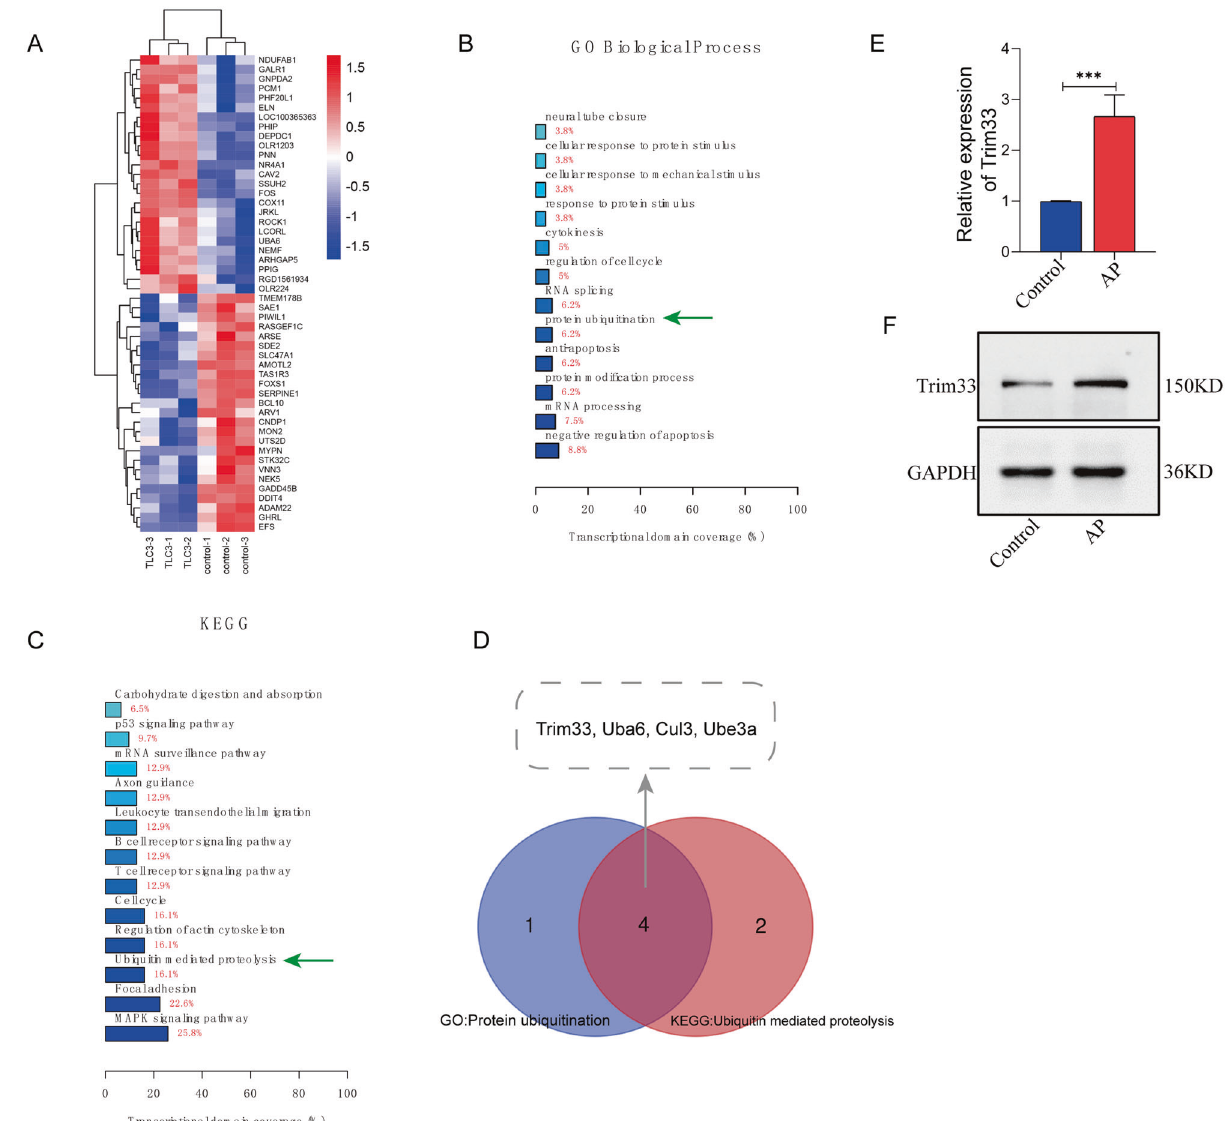
Fig. 1 Trim33 was highly expressed in acute pancreatitis and was related to ubiquitin-mediated protein degradation. A Gene expression differential analysis (log |FC | > 1, p < 0.05); B differential gene GO enrichment analysis; C differential gene KEGG enrichment analysis; D screening of target genes; E Trim33 mRNA was highly expressed in AP; F Trim33 protein was highly expressed in AP ( t -test; *** p <